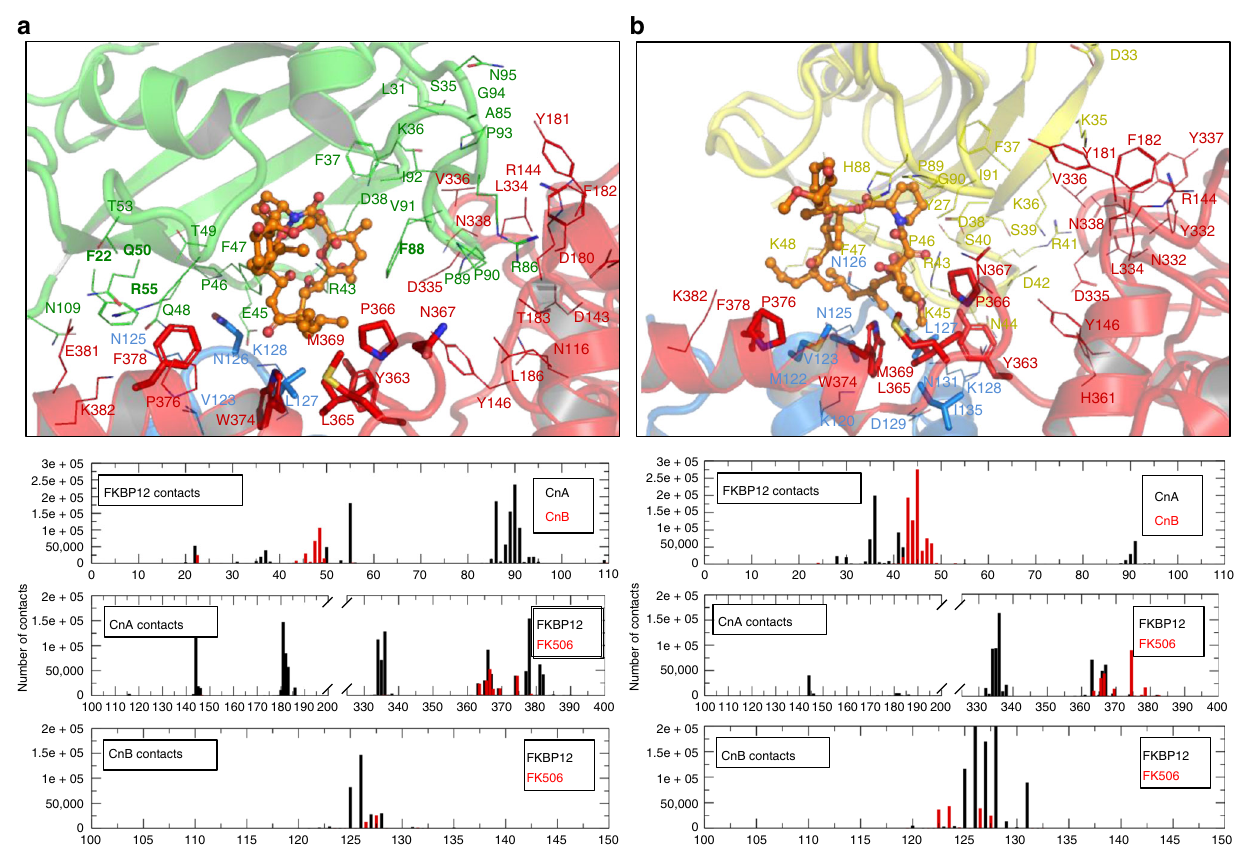
Fig. 5 Binding of FKBP12 – FK506 to A. fumigatus CN. a Cartoon representation of A. fumigatus WT AfFKBP12 – FK506 complex binding to A. fumigatus CN (CnA/CnB) from the MD simulation. Cartoon representations colored as follows: CnA (red), CnB (blue), AfFKBP12 (green), and FK506 (orange sticks and spheres). b Cartoon representation of Human hFKBP12:FK506 complex binding to A. fumigatus CnA/CnB from the MD simulation. Cartoon representations colored as follows: CnA (red), CnB (blue), hFKBP12 (yellow), and FK506 (orange sticks and spheres). Residue labels are shown for clarity and colored to the same color as their protein. Residues (those with more than 2000 contacts in the last 100 ns of the simulation) depicted as lines are contacts between either FKBP12 and CnA or CnB, while sticks are contacts between FK506 and CnA or CnB. Valence states are shown for label clarity. Bar graphs denote all contacts within 6 Å during the last 100 ns of each simulation; top bar graph, FKBP12 contacts to CnA (black) and CnB (red); middle graph, CnA contacts to FKBP12 (black), and FK506 (red), slanted lines denote residues 201 – 324 to which there are no contacts in CnA; bottom graph, CnB contacts to FKBP12 (black), and FK506 (red). See also Supplementary Figs. 7 and 8 and Supplementary Table